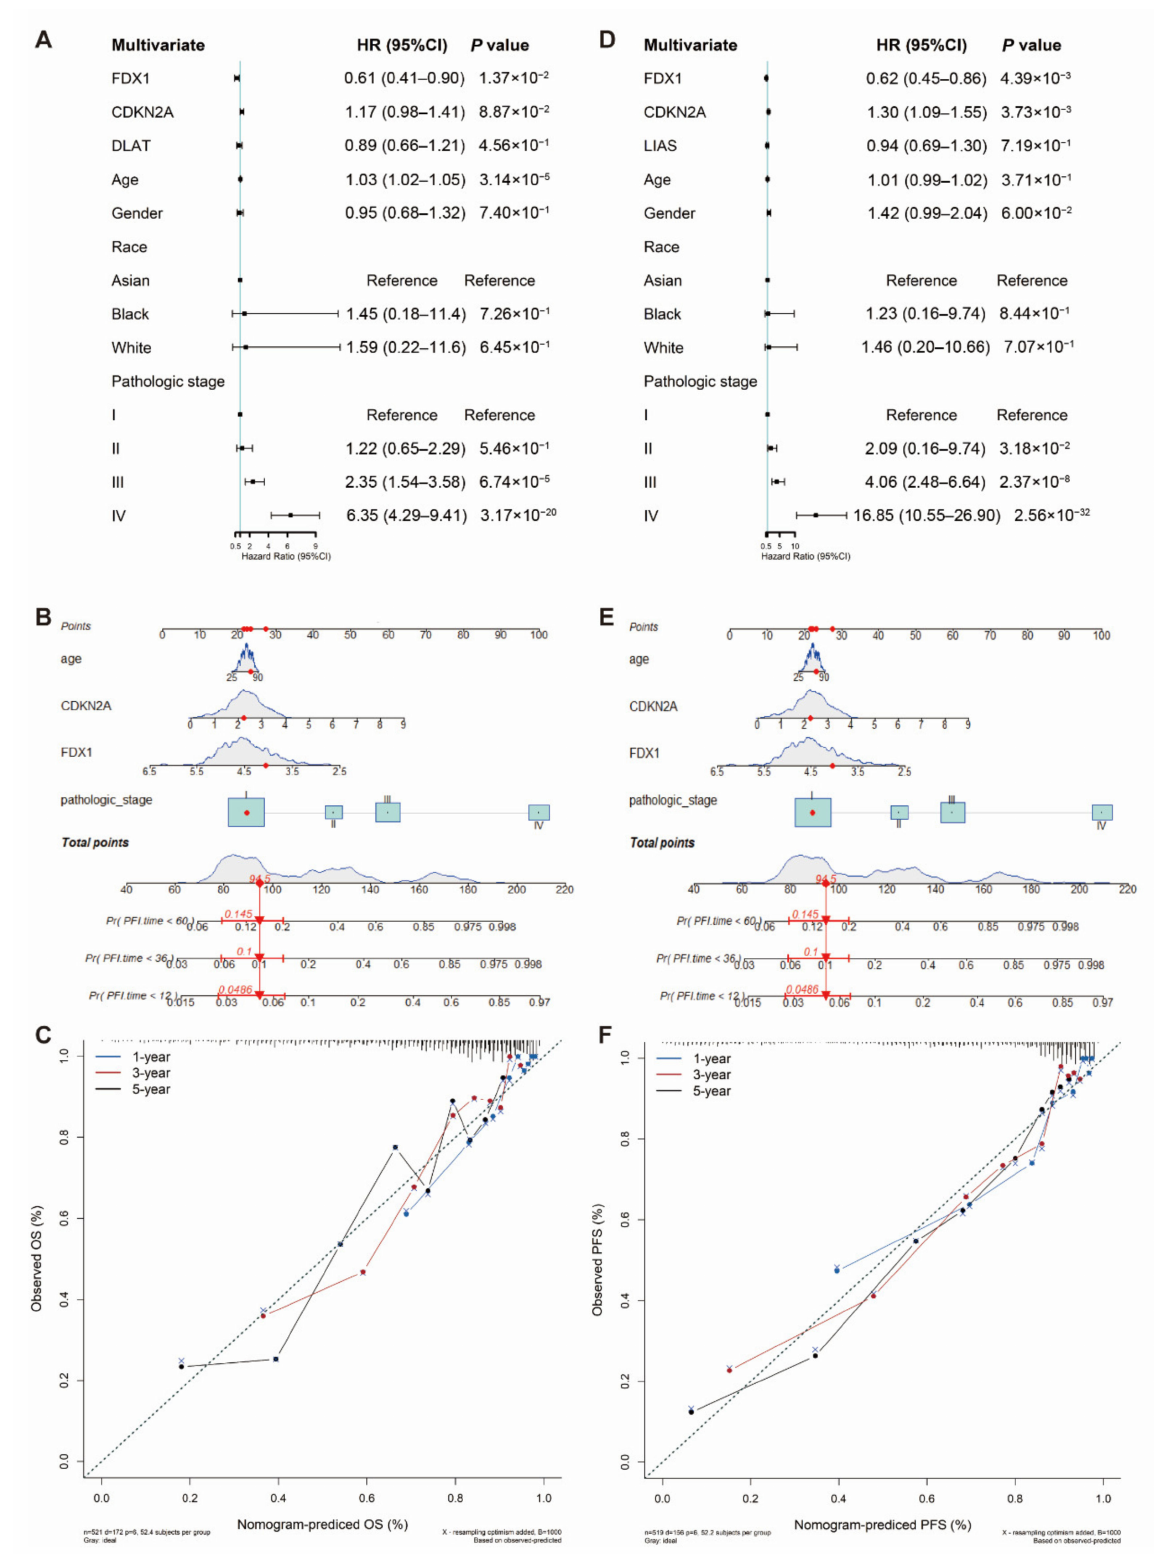
Figure 4. Nomogram development and validation. For ( A ) OS and ( D ) PFS, hazard ratios and p -value of the constituents involved in multivariate Cox regression considering clinical information and prognostic CRGs in ccRCC. Nomogram to predict the 1-year, 3-year and 5-year ( B ) OS and ( E ) PFS rate of LUAD patients. Calibration curve for the ( C ) OS and ( F ) PFS nomogram model in ccRCC. A dashed diagonal line represents the ideal nomogram. CRG: cuproptosis-related gene, ccRCC: clear cell renal cell carcinoma, OS: overall survival and PFS: progression-free